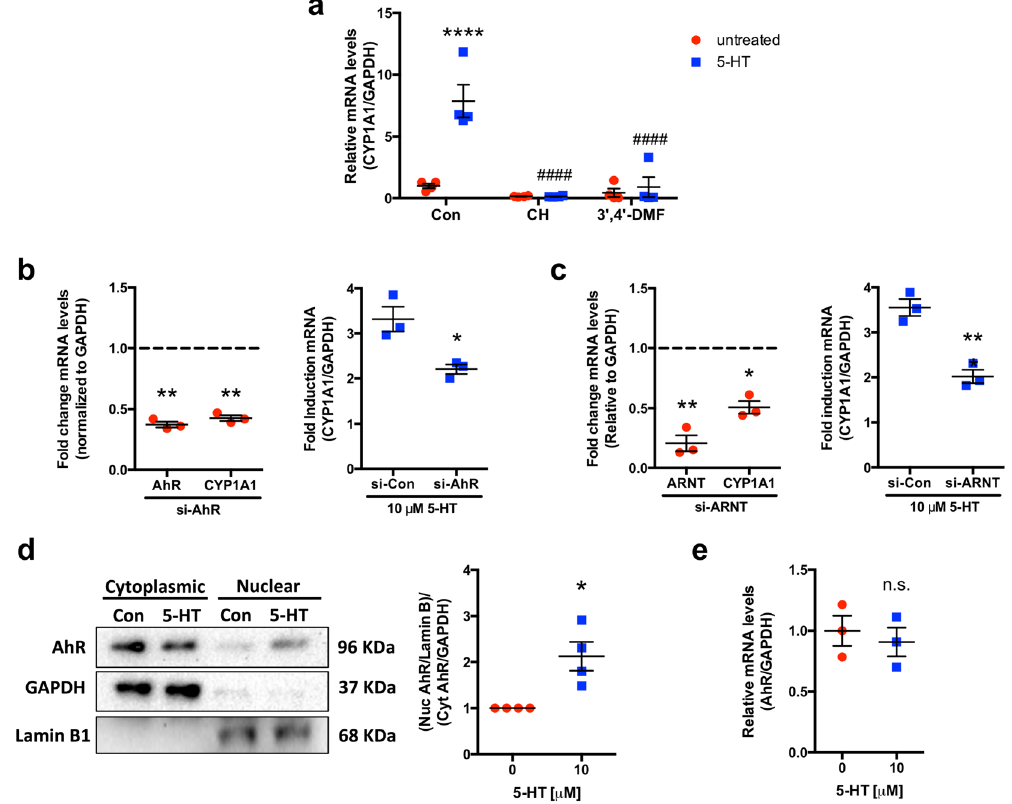
Figure 4. AhR activation is required for 5-HT to induce CYP1A1 mRNA. Caco-2 cells were plated at low density and allowed to differentiate for 10–14 d in medium containing 20% serum before treatments were performed without transfection ( a , d , e ). When transfection was performed, Caco-2 cells were treated beginning 24 h post-transfection ( b , c ). ( a ) Caco-2 cells were treated with vehicle (Con) or AhR antagonists 10 μ M CH- 223191 (CH) and 10 μ M 3 ′ ,4 ′ -dimethoxyflavone (3 ′ ,4 ′ -DMF) for 1 h before co-treatment of each antagonist with 5-HT (10 μ M) for 24 h in serum-free medium. Data represent the relative expression of CYP1A1 mRNA quantified by qPCR. Data were analyzed by 1-way ANOVA followed by Tukey’s multiple comparison’s test ( n = 4). ( b , c ) Caco-2 cells were transfected with control siRNA (si-Con), AhR siRNA (si-AhR), or ARNT siRNA before treatment with 5-HT (10 μ M) for 8 h (si- AhR ) or 24 h (si- ARNT ) in serum-free medium. AhR , ARNT , and CYP1A1 mRNA expression were determined in untreated cells by qPCR and results are expressed as fold change compared to control siRNA. Data analyzed by paired 2-tailed Student’s t -test. Unpaired 2-tailed Student’s t -test was used to compare CYP1A1 mRNA induction after 5-HT treatment in control siRNA vs. AhR or ARNT siRNA transfected cells ( n = 3). ( d ) Caco-2 cells were treated with 5-HT (10 μ M) for 4 h in serum- free medium before nuclear and cytoplasmic extracts were isolated and Western blotting was performed for AhR. Nuclear AhR was normalized to Lamin B1 and cytoplasmic AhR was normalized to GAPDH. The ratio between nuclear and cytoplasmic AhR as determined by densitometry was analyzed by paired 2-tailed Student’s t -test ( n = 4). Full-length blots are shown in Supplementary Figure S1. ( e ) Caco-2 cells were treated with 5-HT (10 μ M) for 24 h in serum-free medium. Data represent the relative expression of AhR mRNA quantified by qPCR ( n = 3). * P < 0.05, ** P < 0.01, **** P < 0.0001 vs. untreated, control siRNA, or no 5-HT. #### P < 0.0001 vs. 5-HT treatment without AhR antagonist. n.s. = not significant. Red circle = untreated, blue square =